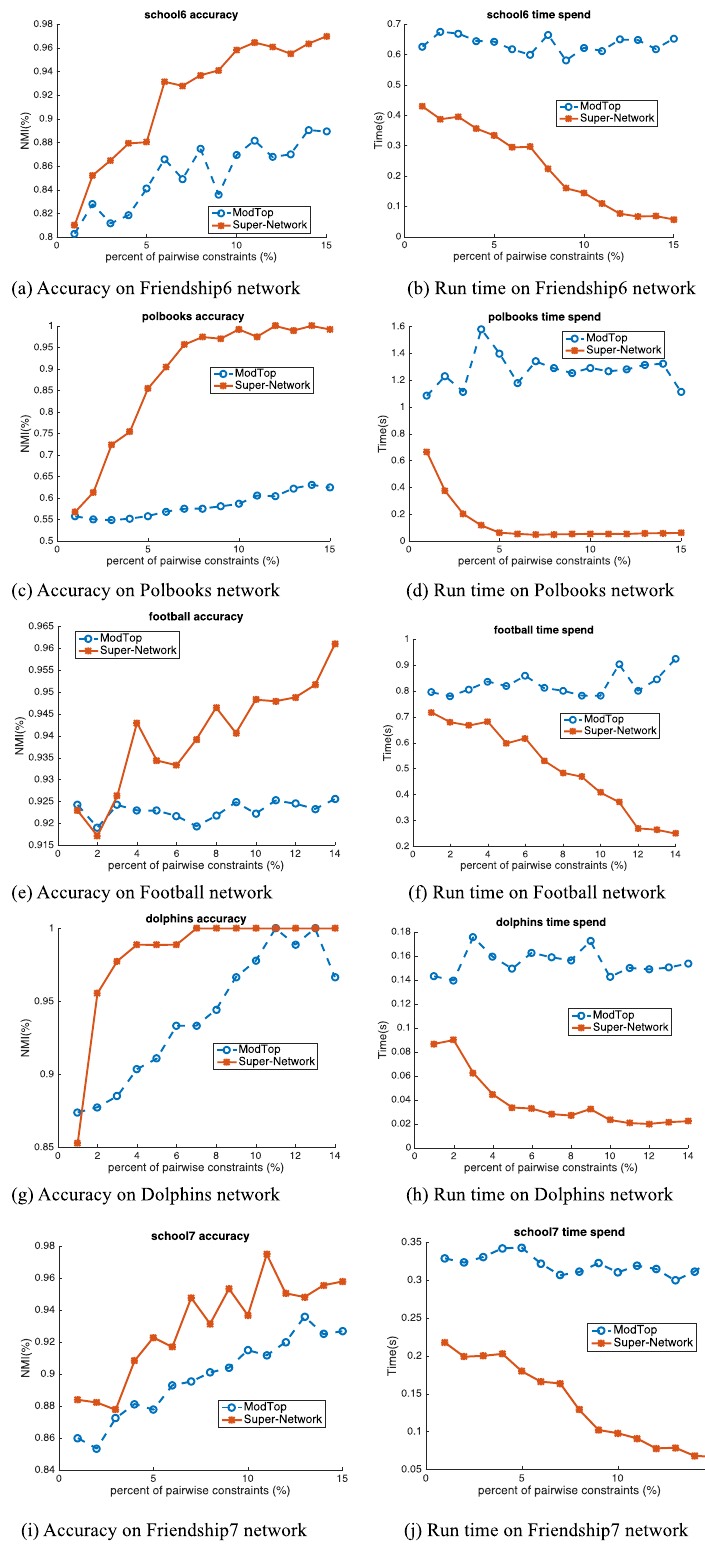
Figure 6. Accuracy (NMI) and run time (spent time in second) on real world networks based on